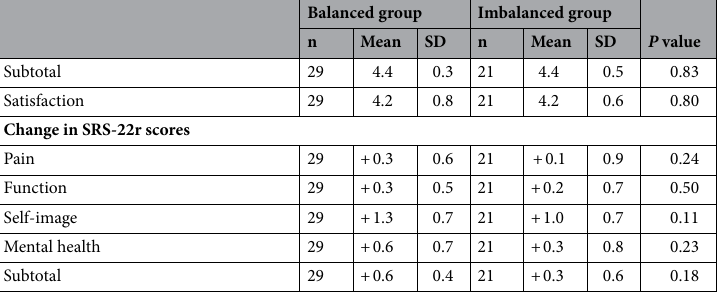
Table 3. Patient characteristics, radiographic data, and SRS-22r scores of the balanced group and imbalanced group. UIV upper instrumented vertebra, MSLV modified Shinshu line vertebra, PT proximal thoracic, MT main thoracic, C7PL-CSVL absolute length between C7 plumb line and central sacral vertical line, CA clavicular angle, |RSH| absolute radiographic shoulder height, AVT apical vertebral translation, SRS-22r Scoliosis Research Society 22r questionnaire.